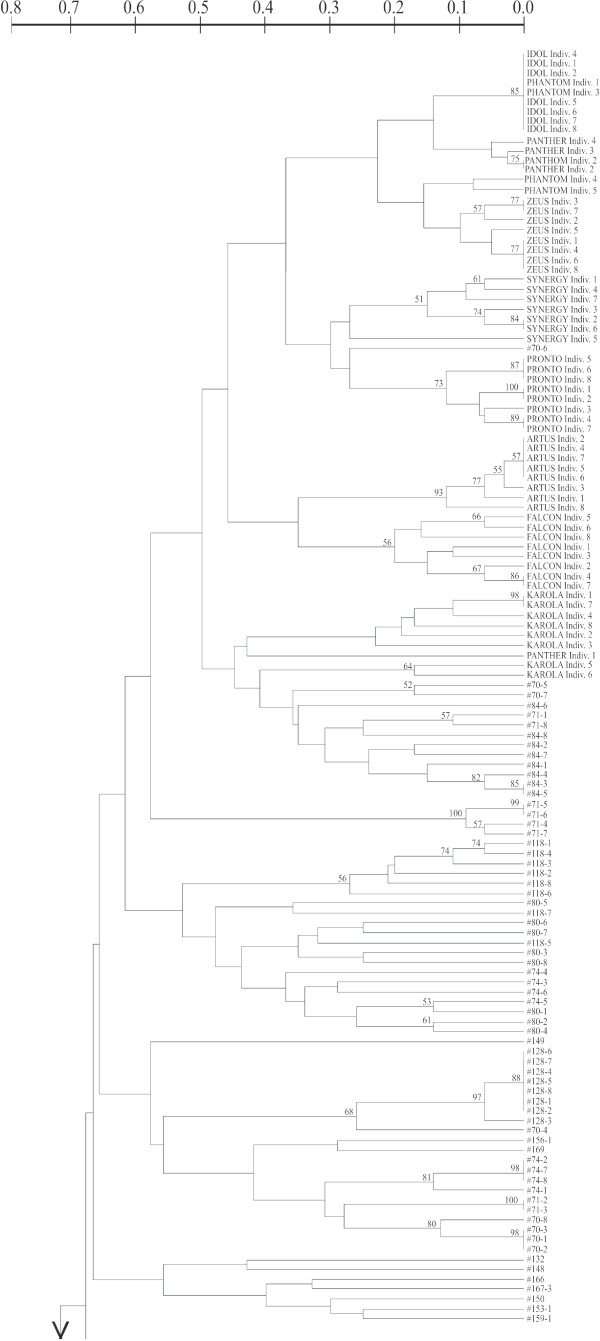
Relationship among single individuals of B. napus based on Nei and Li genetic distances and UPGMA. For comparison individuals from three commercial varieties of B. rapa were also included. Nei and Li [48] genetic distances and UPGMA method implemented in Treecon ver. 1.b software [49] were used. For this analysis each SSR allele was coded as a single locus with two states, 0 (absent) or 1 (present) [50]. The consistency of each node was assayed by bootstrapping (i.e. resampling with replacement) with 1000 replicates using Treecon ver. 1.3b software [49]. Only bootstrap values (%) over 50 are reported in the figure.